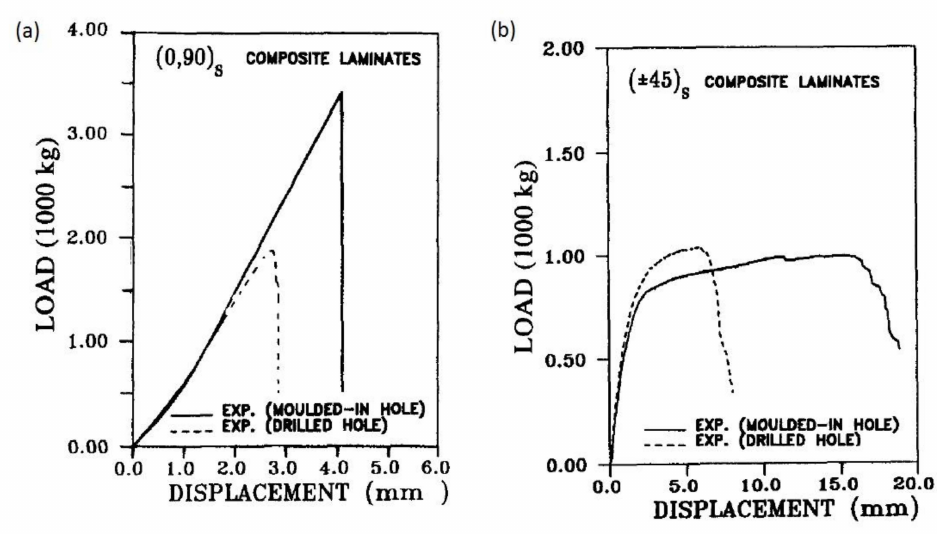
Figure 28. Typical load / displacement relationships for OHT tests with moulded and drilled holes